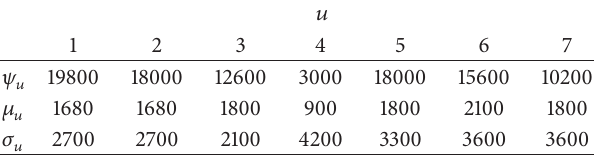
Table 1: Value of demand related parameters.